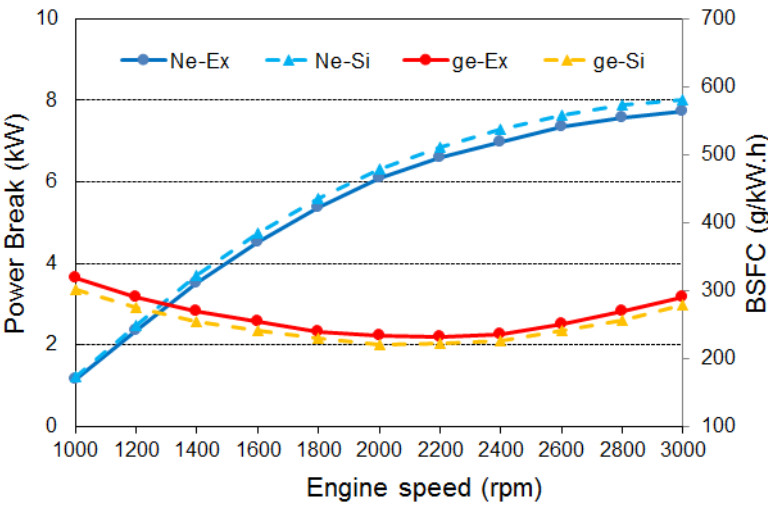
Figure 2. Model validation.